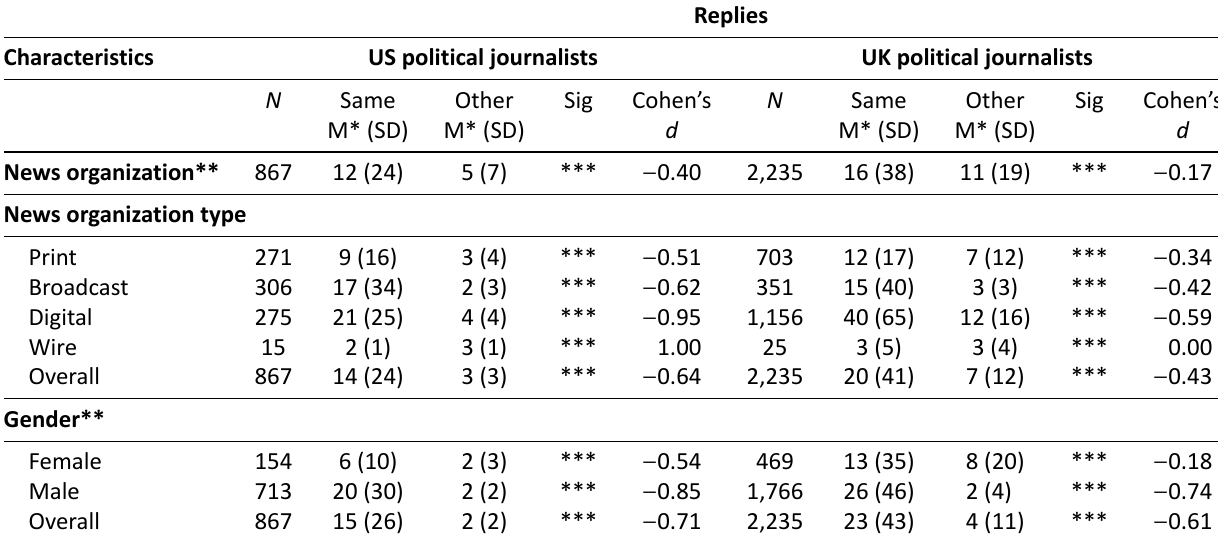
Table 3. Shared characteristics in